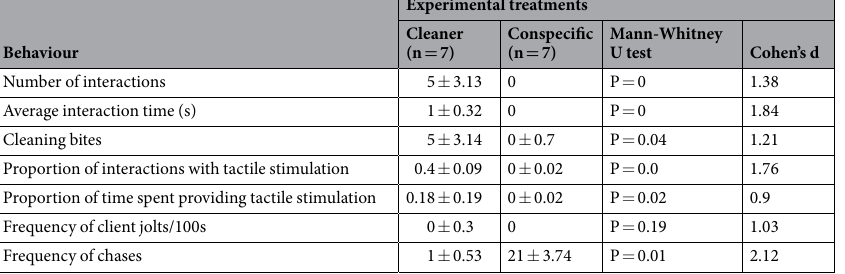
Table 1. Observed behavioural measures for each experimental treatment. Medians ± Standard Error (SEM) are provided for each behavioural measure.